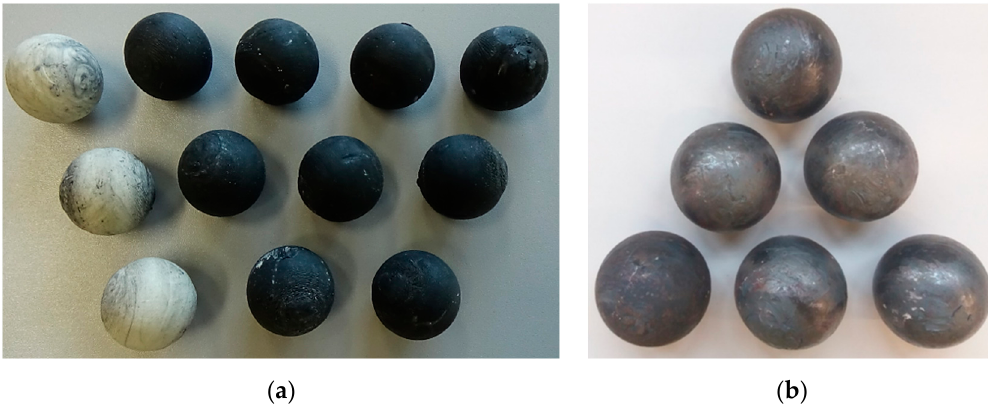
Figure 12. Helically rolled balls of ( a ) plasticine with Ø28.5 mm diameter; ( b ) steel with Ø57 mm diameter.